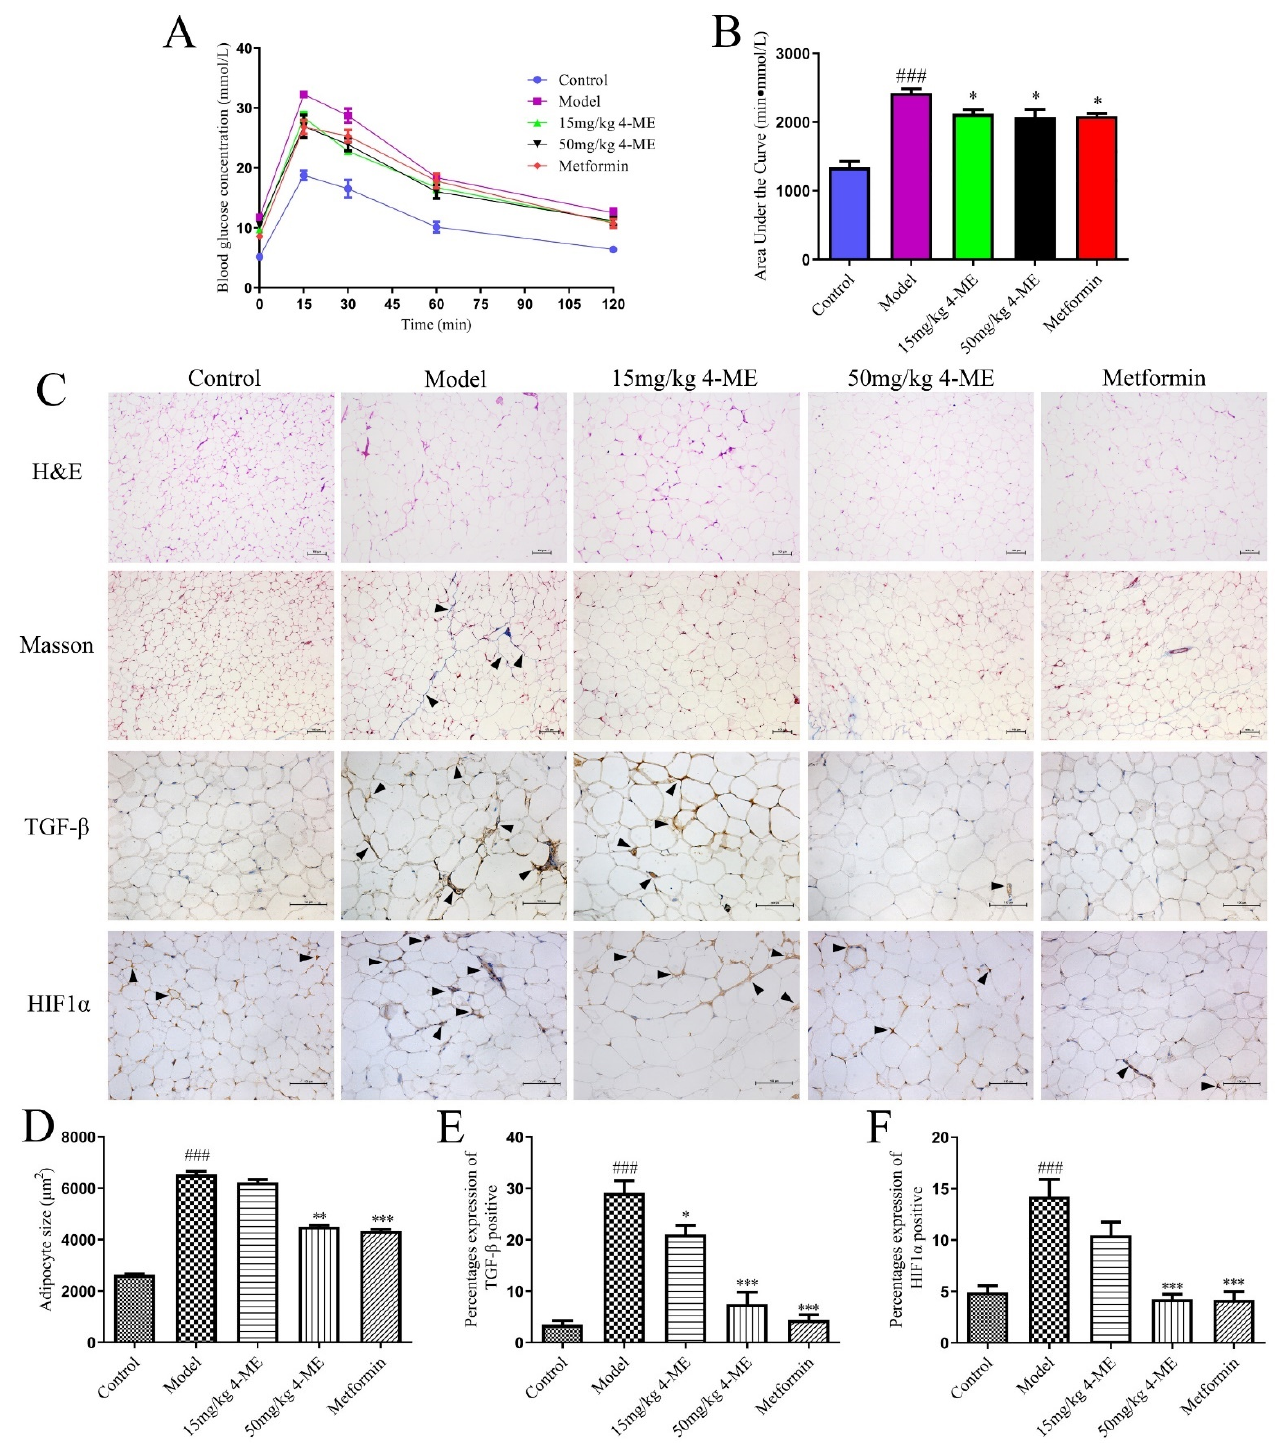
Figure 1. Effects of 4-ME upon intraperitoneal glucose tolerance test (IPGTT) and adipose tissue microenvironment in HFD-fed mice. ( A ) IPGTT ( n = 5). ( B ) The area under the curve of IPGTT ( n = 5). ( C ) The rows from the top to the bottom represent H&E staining (original magnification, 100×), Masson staining (100×), and immunostaining of TGF- β antibody (200×) and HIF1 α (200×) in adipose tissue sections, respectively. ( D ) The size of adipocytes ( n = 300). ( E,F ) Quantification for the percentage expression of TGF- β and HIF1 α protein in panel ( n = 4). Arrowheads indicate pathological changes. Values were given as mean ± SEM; ### p < 0.001 compared with the Control group, * p < 0.05, ** p < 0.01, *** p < 0.001 compared with the Model